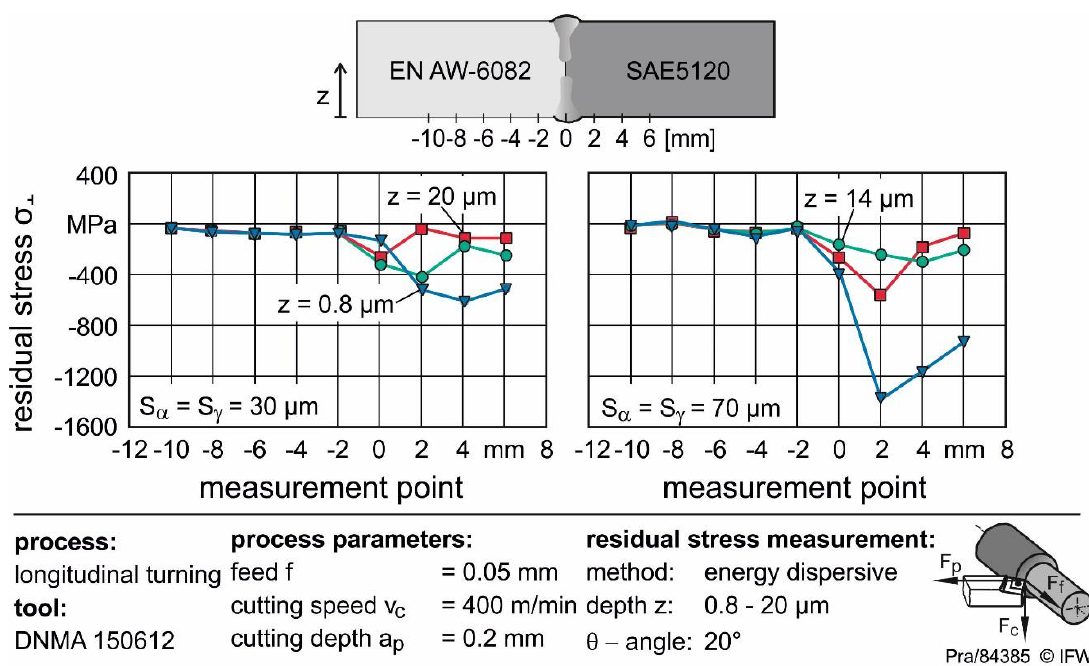
Figure 10. Influence of cutting edge geometry on transversal residual stress parallel to the surface in different depths of turned steel-aluminium alloy welded shaft.